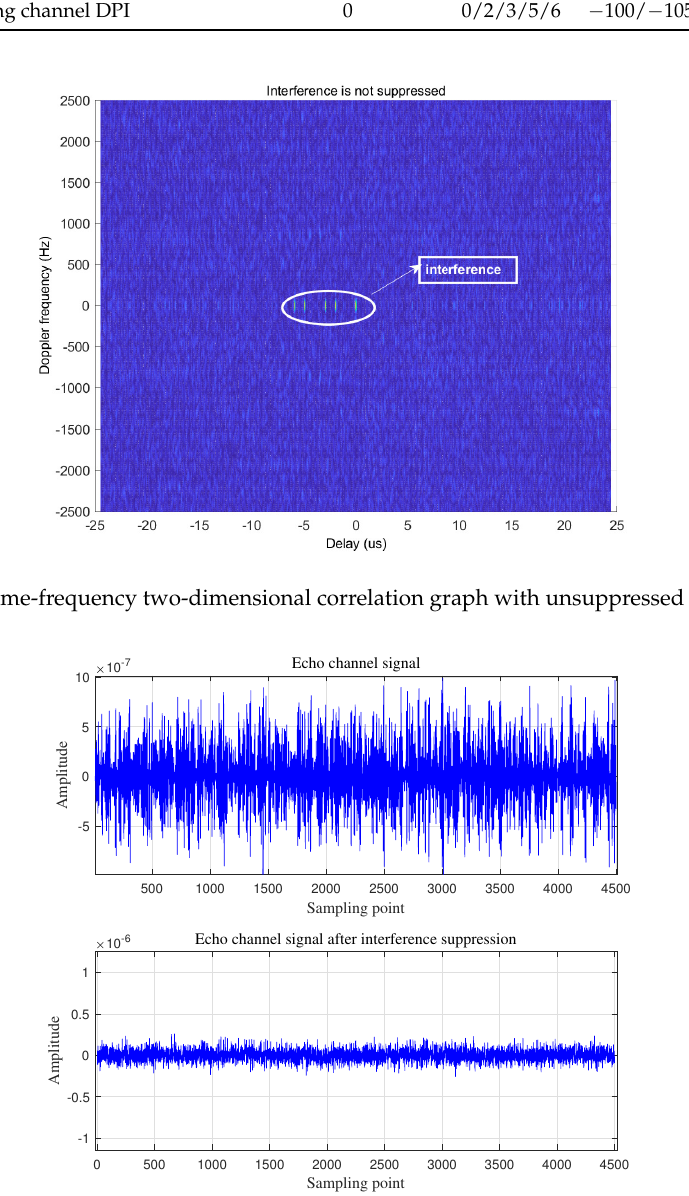
Figure 11. Monitoring channel signal before and after interference